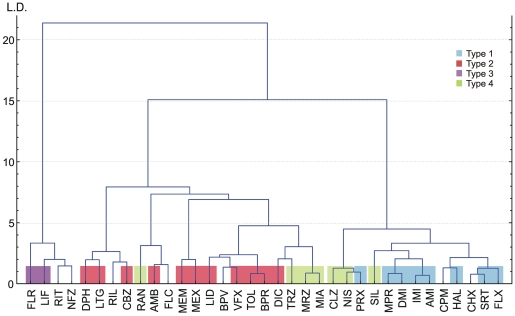
Clustering based on selected chemical descriptors.Result of a cluster analysis based on seven chemical descriptors: logP, logD7.3, MW, polar surface area, aromatic atom count, minimal projection area and log N(pKa). (Ward’s method was used as amalgamation rule, with Euclidean distance measure.) L.D.: Linkage distance.